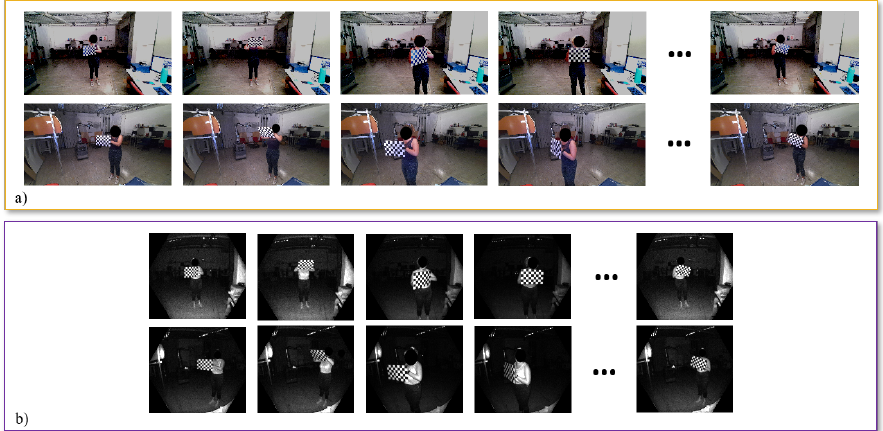
Figure 8. ( a ) RGB and ( b ) IR image samples of the chessboard. Several positions and orientations have been considered to optimize the results of the